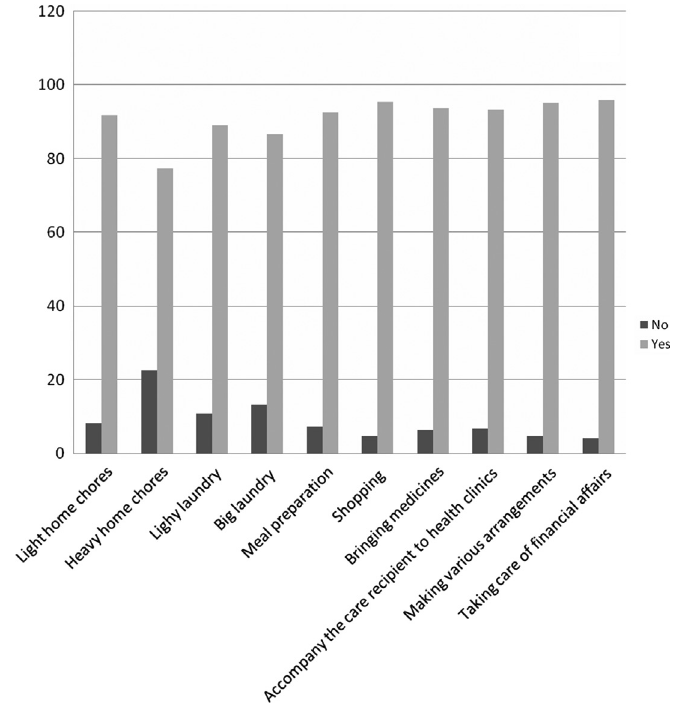
Figure 2. IADL tasks performed by primary caregi v ers before and after the employmnet of a migrant homecare worker (percentages)